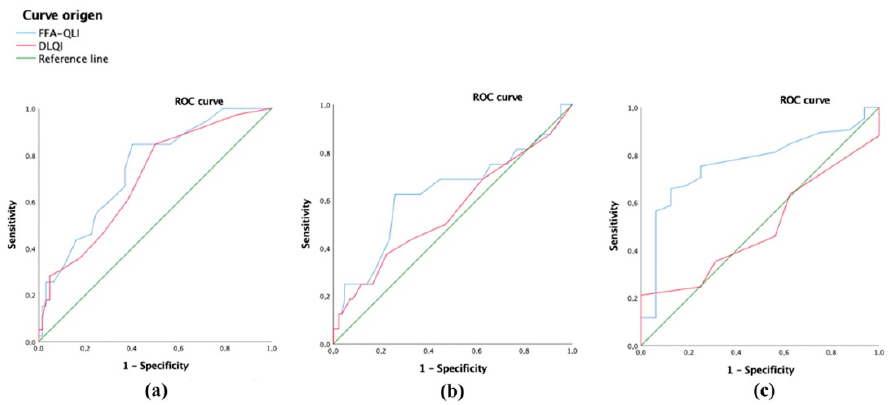
Figure 3. Receiver operating characteristic (ROC) curve to assess discriminative power differences between scales to select ( a ) long-lasting cases of FFA, ( b ) patients with facial papules, and ( c ) patients with eyebrow alopecia. The FFA-QLI showed higher discriminative power than the DLQI to discriminate patients with long-lasting FFA ( a ) and eyebrow alopecia ( c ). However, although the FFA-QLI had more power to select patients with facial papules than the DLQI ( b ), it did not have enough power to do so.